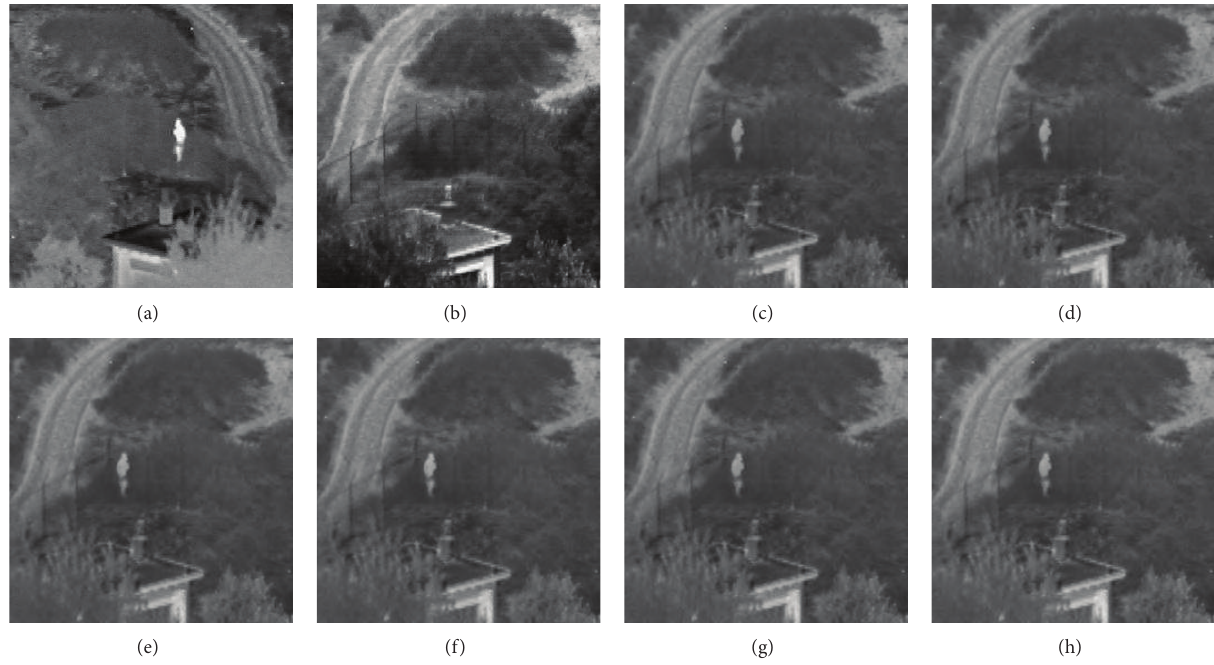
Figure 4: (a) Infrared image, (b) visible light image, (c) fusion result of average scheme, (d) fusion result of mean scheme, (e) fusion result of variance scheme, (f) fusion result of PCA scheme, (g) fusion result of MI scheme, and (h) fusion result of the proposed method.